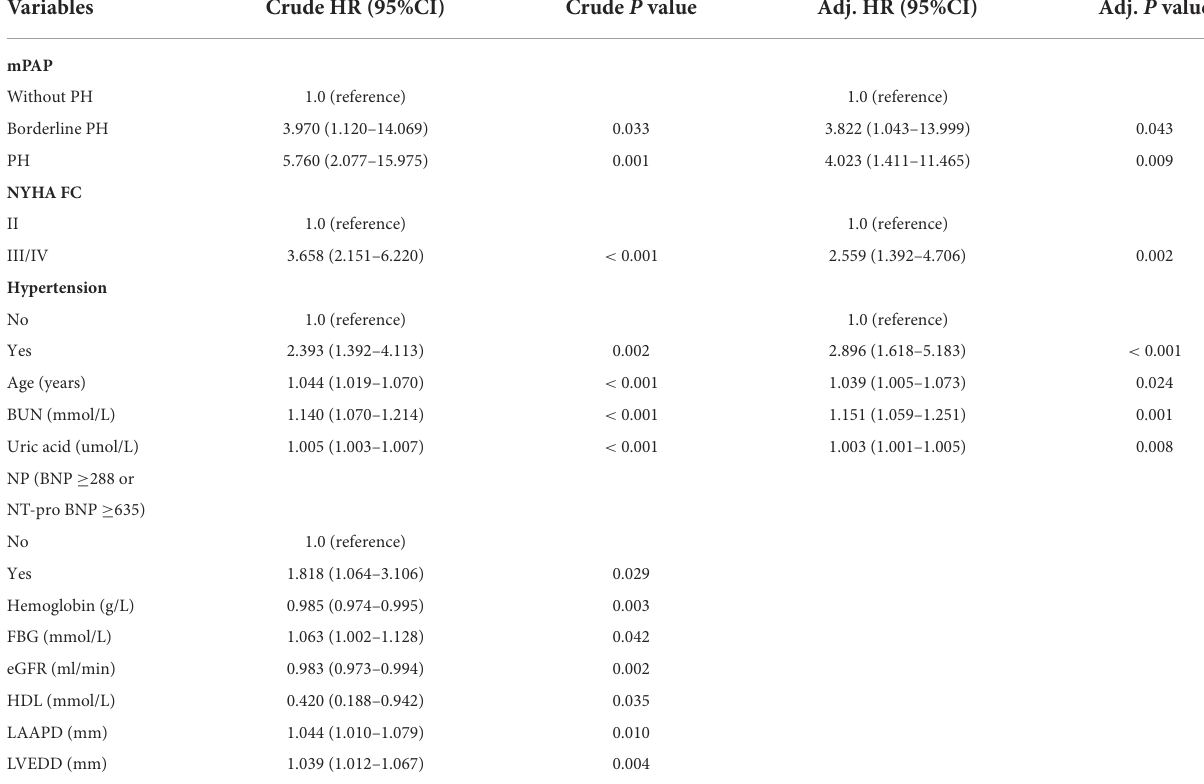
TABLE 2 Hazard ratio for mortality among patients assigned to the borderline PH and traditionally defined PH groups compared with the non-PH group.